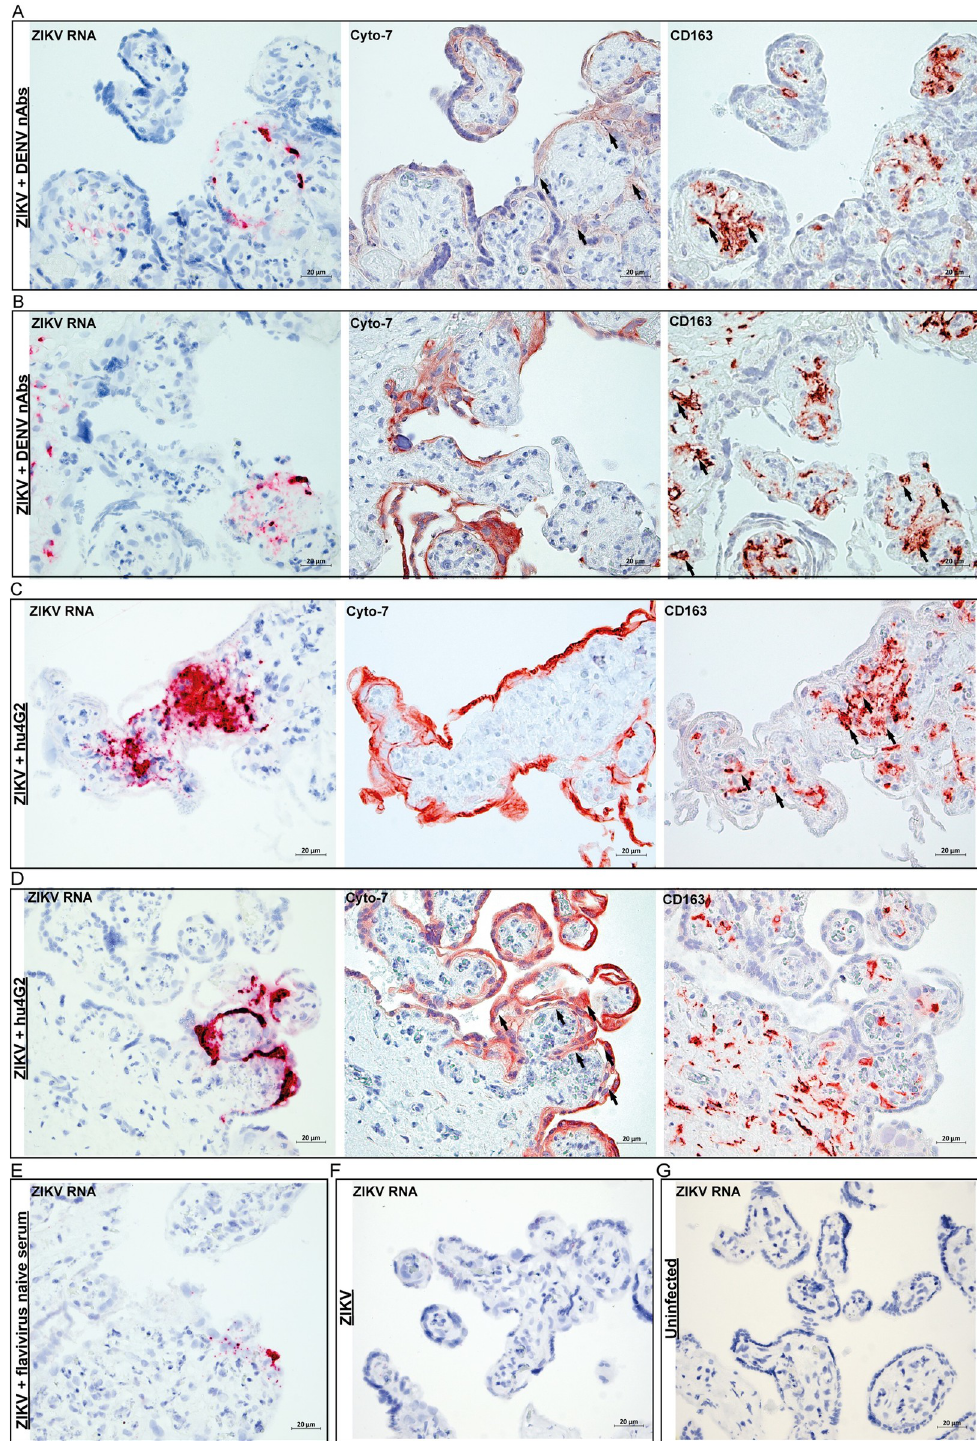
Fig 4. ZIKV infects Hofbauer cells and trophoblasts in placental explants in presence DENV nAbs. A-D: Representative pictures of ZIKV infection in Hofbauer cells (CD163) and trophoblasts (Cyto-7), in term human placental explants infected with ZIKV that was pre-incubated with human serum containing DENV-2 nAbs ( A&B) or a humanized pan-flavivirus monoclonal antibody (hu4G2, C&D) . Arrows indicate cells stained with either Cyto-7 or CD163 that correspond with cells in which ZIKV RNA was detected. E-G: Staining for ZIKV RNA in placental explants infected with ZIKV+flavivirus na ï ve serum (E) , only ZIKV (F) or uninfected (G) . All tissues were stained six days after (mock) infection.